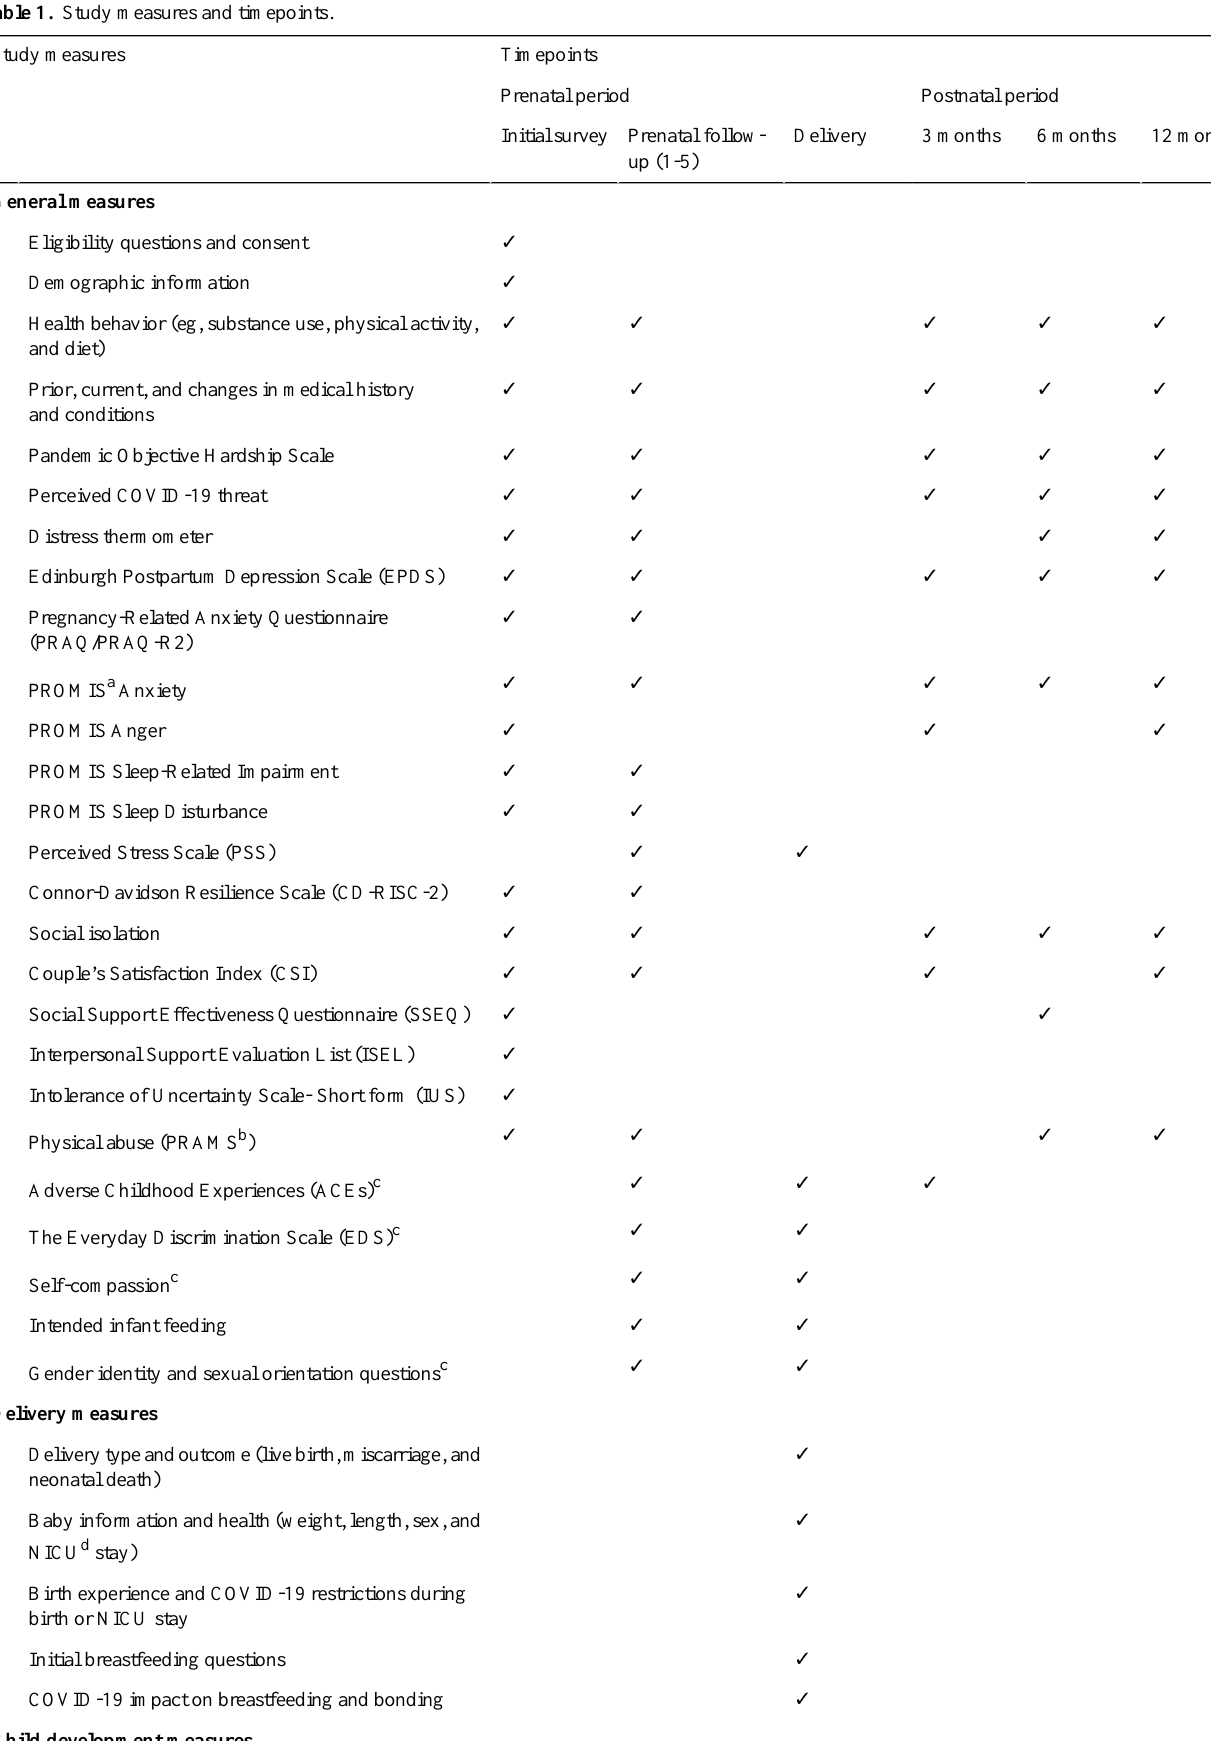
Table 1. Study measures and